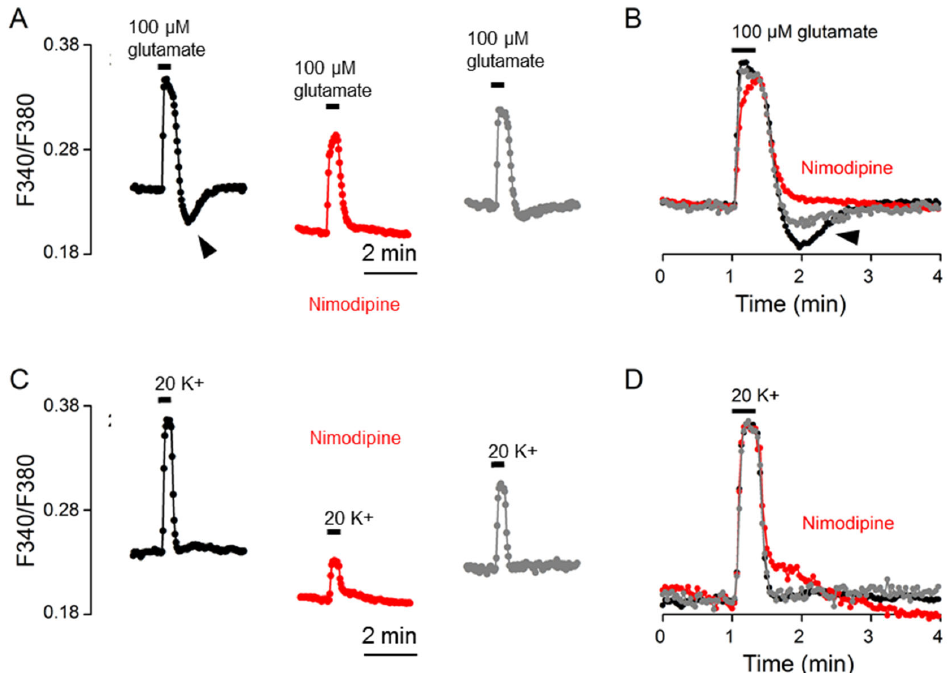
Figure 7. Nimodipine effects on the Ca 2+ response to 100 µ M glutamate ( A , B ) and 20 mM K + ( C , D ) from the same cells. ( A , C ) A representative experiment (an average of 16 cells) showing the effects of 2 µ M nimodipine on the Ca 2+ responses to 100 µ M glutamate ( A ) and 20 mM K + ( C ). ( B , D ) Superimposition of the Ca 2+ responses in the control (black traces), in 2 µ M nimodipine (red traces), and after washout (grey traces) elicited by 100 µ M glutamate ( B ) and by 20 mM K + ( D ). Note that nimodipine eliminated rebound Ca 2+ suppression (marked by arrowheads) ( A , B ), markedly reduced the amplitude of Ca 2+ response to 20 mM K + ( C ), but had no effect on Ca 2+ half-decay time ( B , D ). Similar results were also obtained from 4 other experiments.